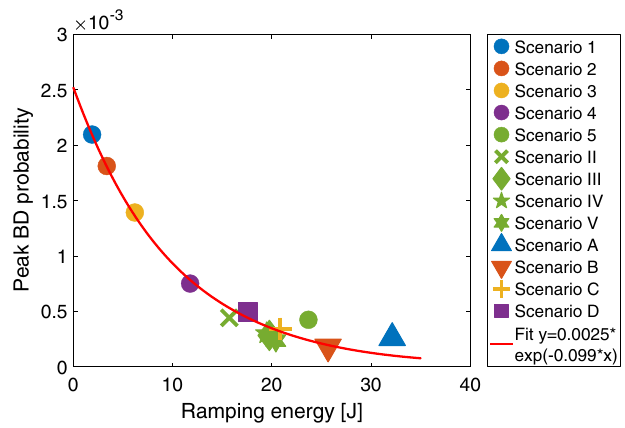
FIG. 5. Peak BD probability during linear voltage recovery as a function of the ramping energy. Also a fit describing an exponential decay is shown.